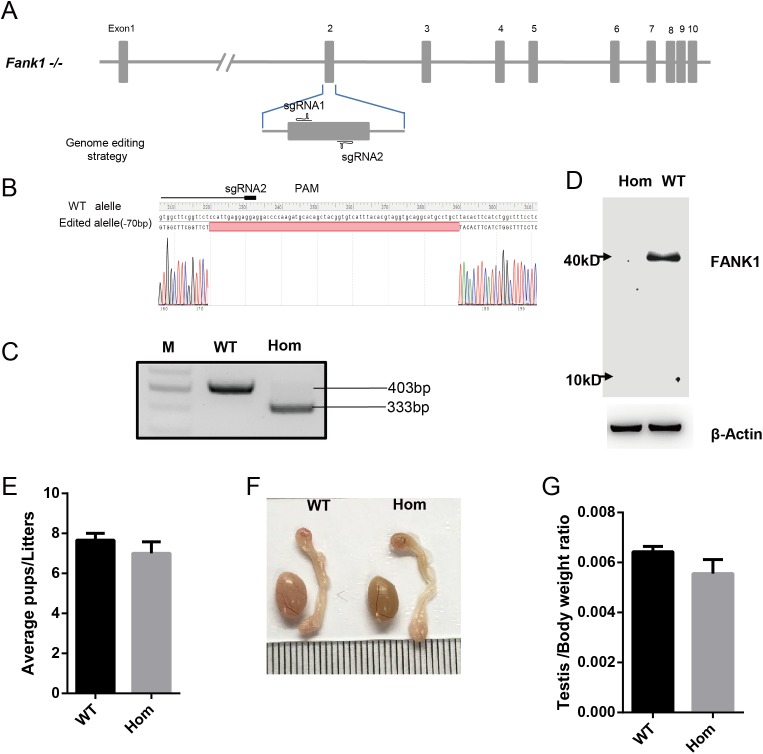
Fank1−/− mice are fertile.(A) Schematic diagram of CRISPR/Cas9 targeting strategy, the sgRNAs were designed on the basis of exon 2 of Fank1; (B) A 70-bp deletion of Fank1 exon 2 was detected in Fank1−/− mice by Sanger sequencing and (C) agarose gel electrophoresis analysis; (D) FANK1 was not detected in Fank1−/− testis by western blot; (E) average pups per litter of wild-type and Fank1−/− mice, n = 3, P > 0.05; (F) testis and epididymis from wild-type and Fank1−/− adult mice; (G) average testis weight/body weight, n = 3, P > 0.05.